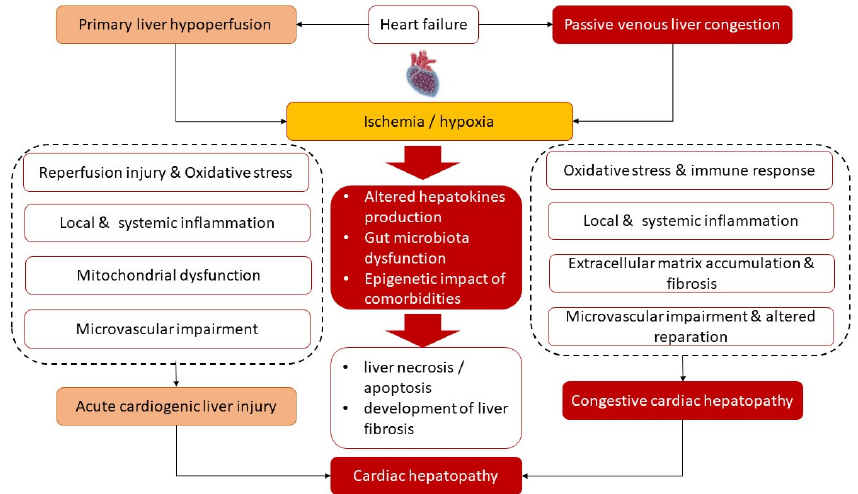
Figure 1. Most common underlying mechanisms of the pathogenesis of cardiac hepatopathy.